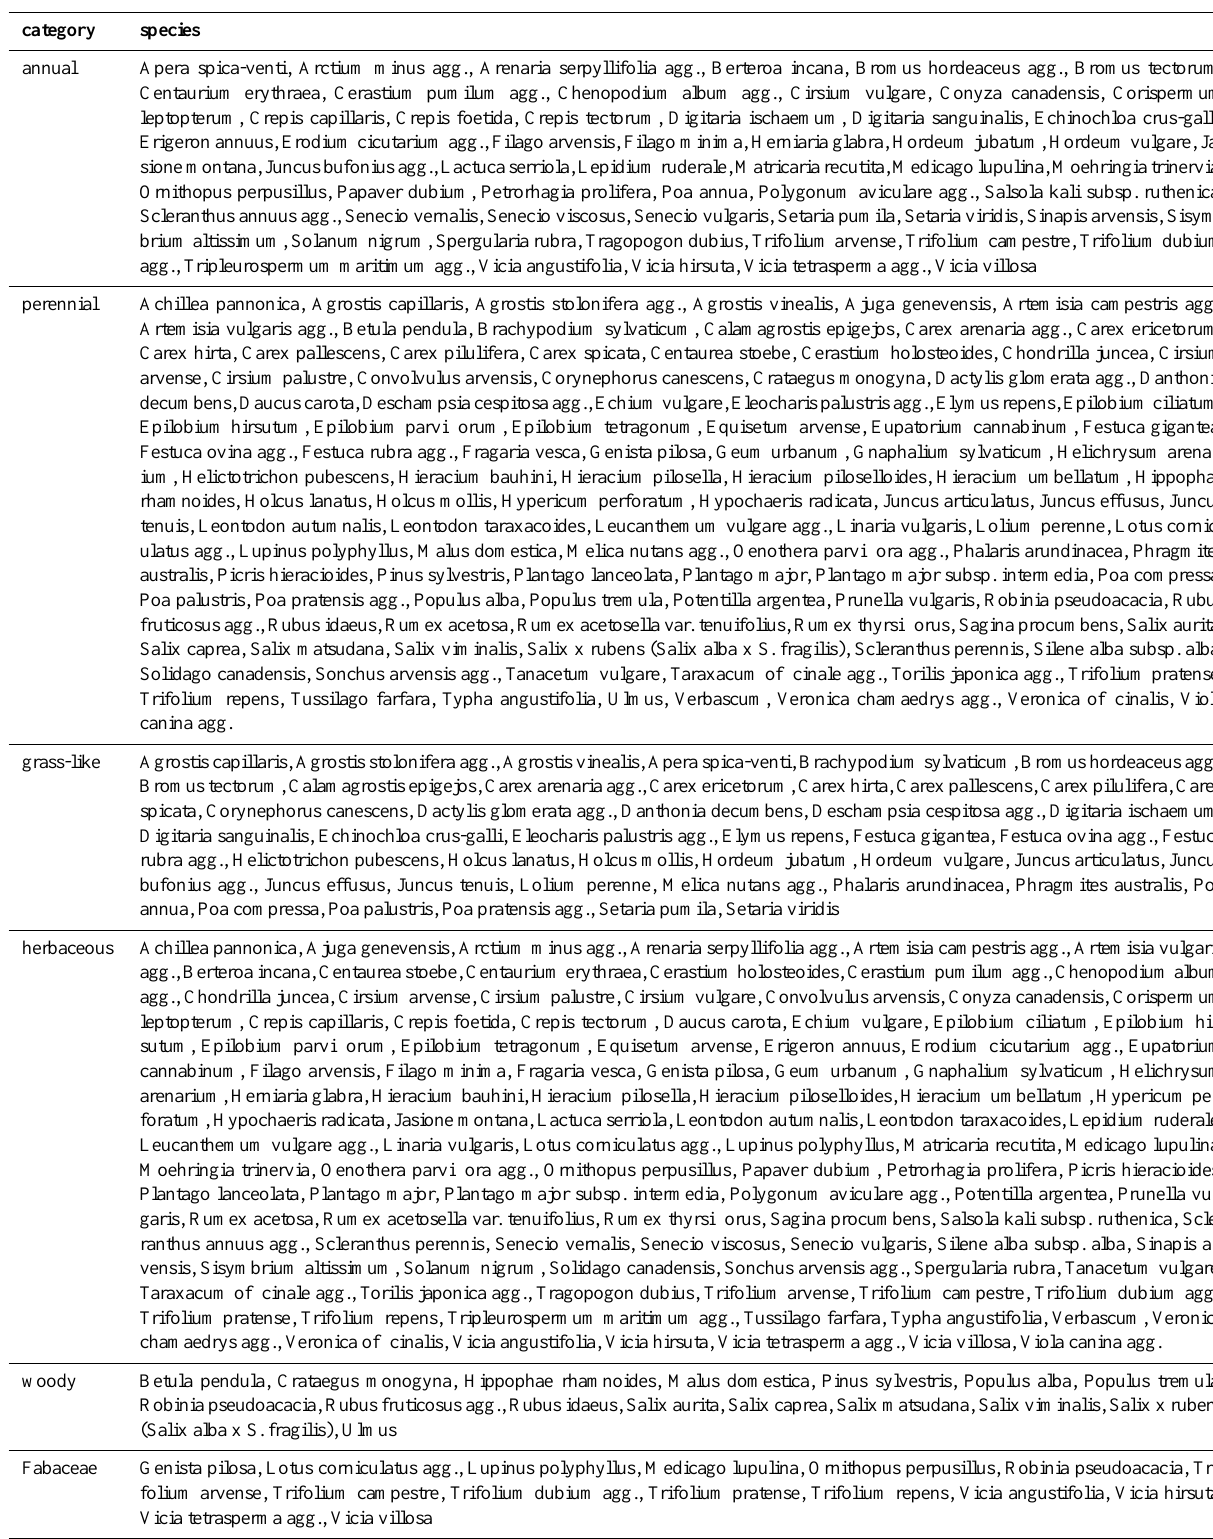
Table 1. Vascular plant species found at the catchment (in alphabetical order) and their allocation to groups as used in this study. See Table 3 for cover values of these